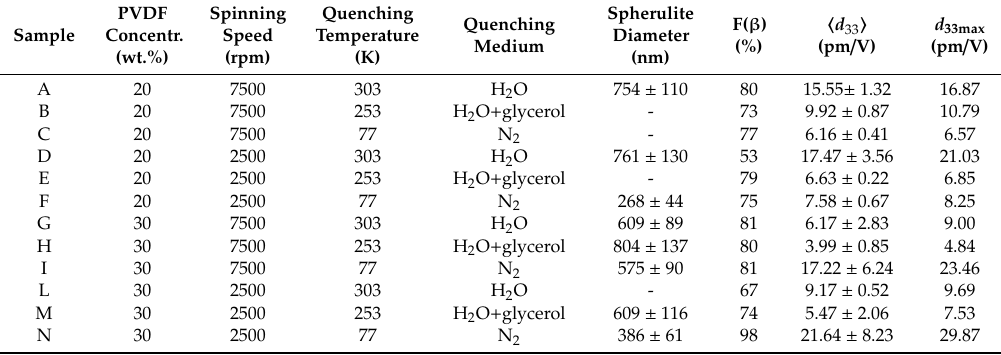
Table 1. List of the produced specimens of Poly(vinylidene fluoride) (PVDF) thin films, production conditions and piezoelectric properties. PVDF Sample